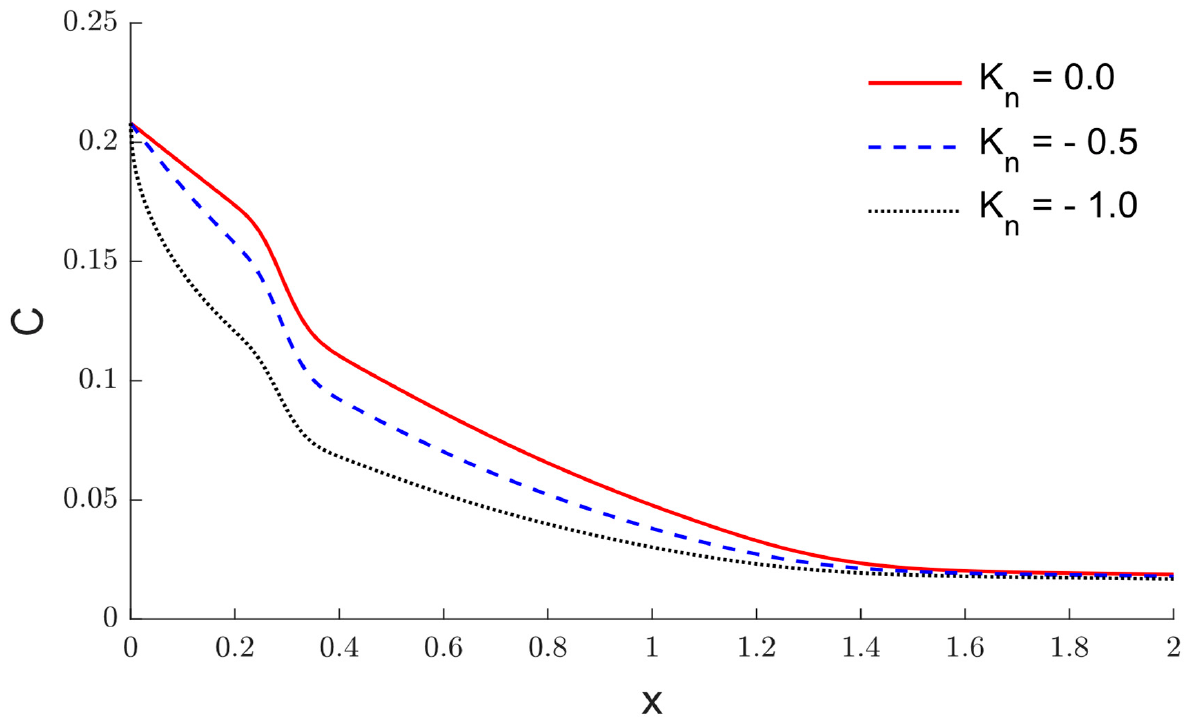
Figure 3. The impact of variable thermal conductivity and diffusivity in the concentration variation C via the distance x when τ o = τ 1 = 0.05 .